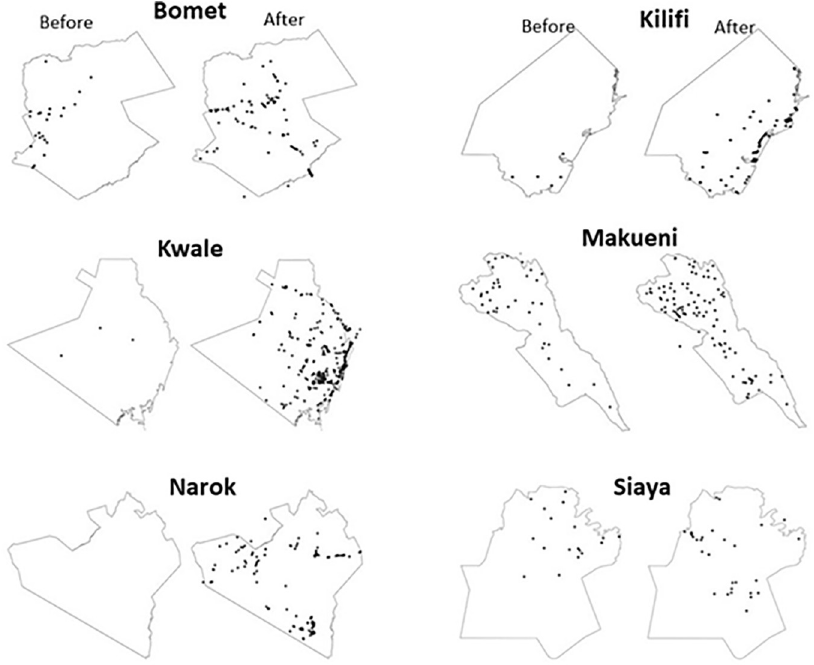
Fig 3. Spatial distribution of disease reporting before and after KABS mobile phone application introduction in Bomet, Kilifi, Kwale, Makueni, Narok, and Siaya Counties of Kenya.